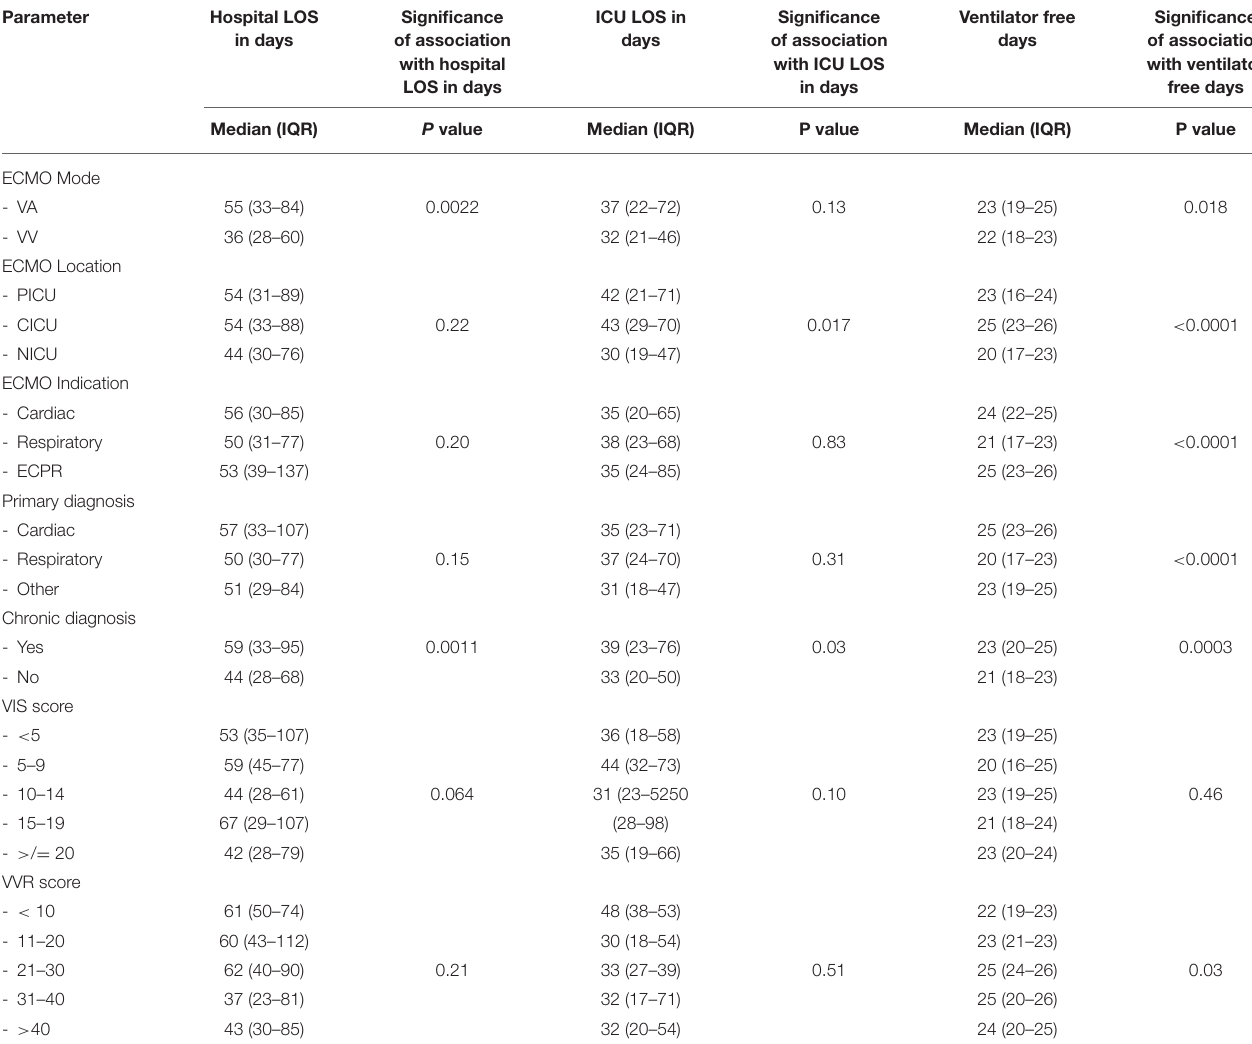
TABLE 5 | Association of predictor variables with Hospital length of stay (LOS), Intensive care unit length of stay (LOS) and Ventilator free days.